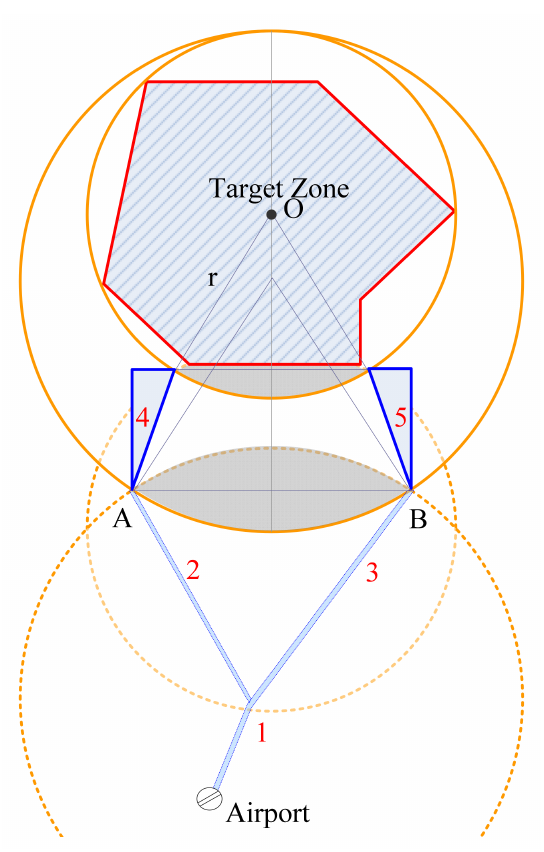
Figure 6. Optimal airspace distribution in direction localization.